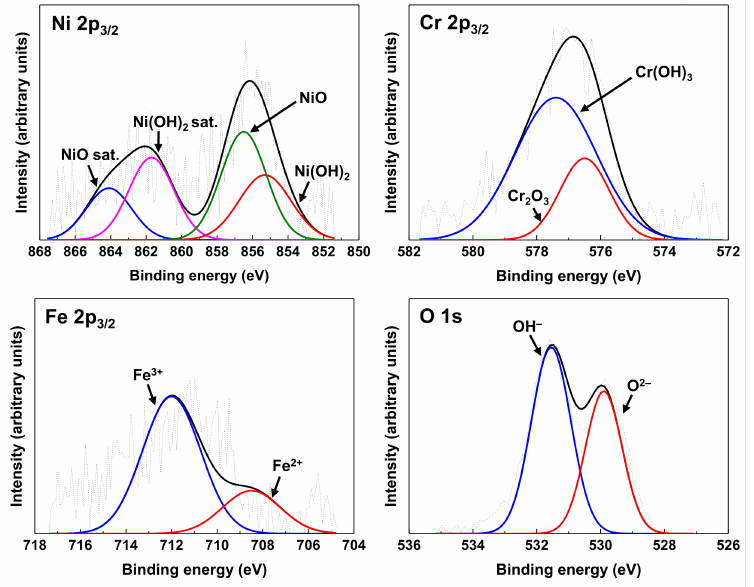
Figure 7. XPS spectra of Ni, Cr, Fe, and O from the oxide formed on Alloy 690 under the Case #1 condition.